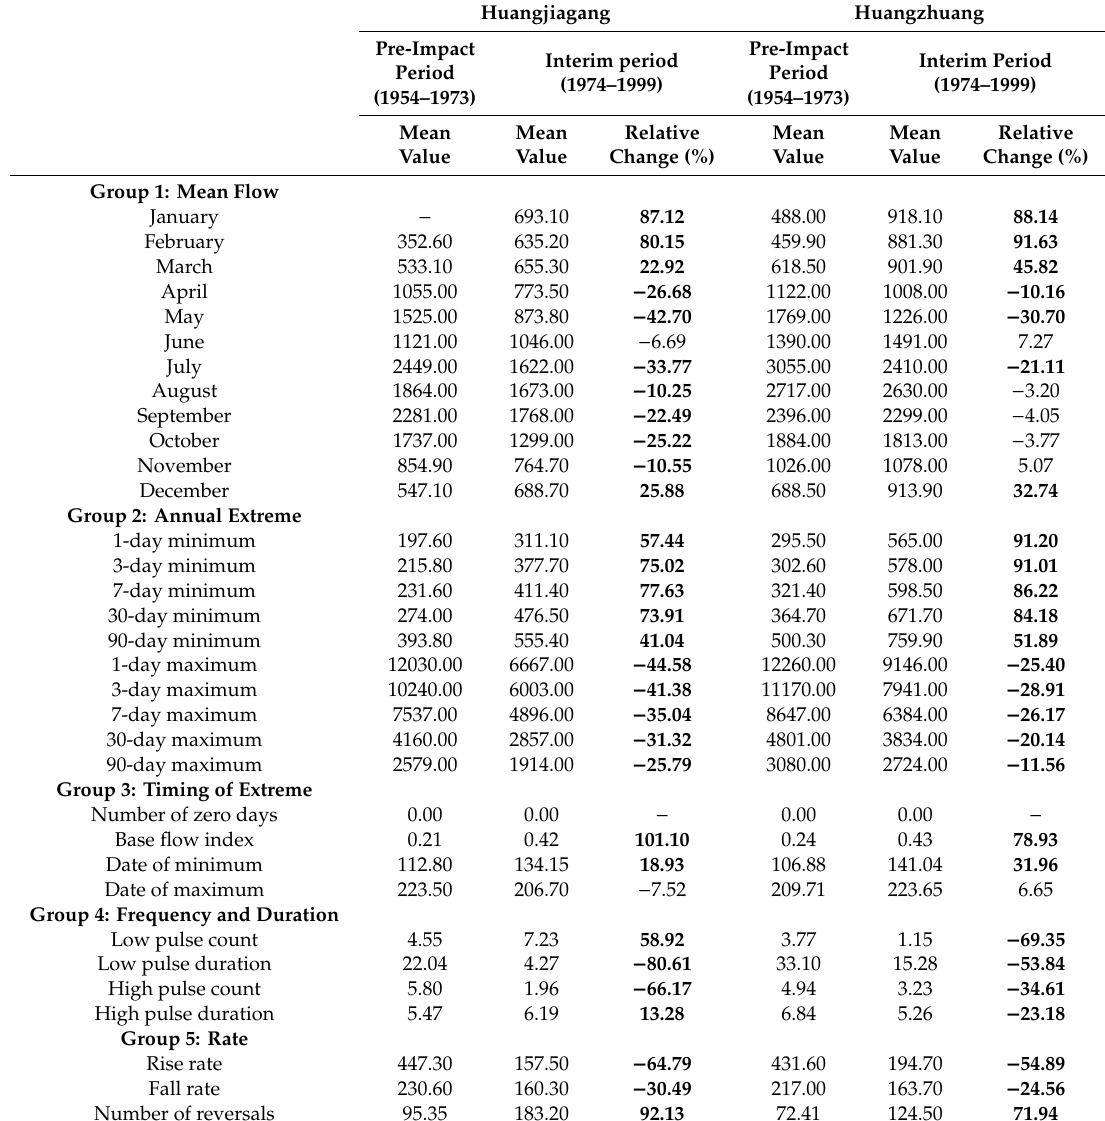
Table 3. Changes of IHA metrics in the interim